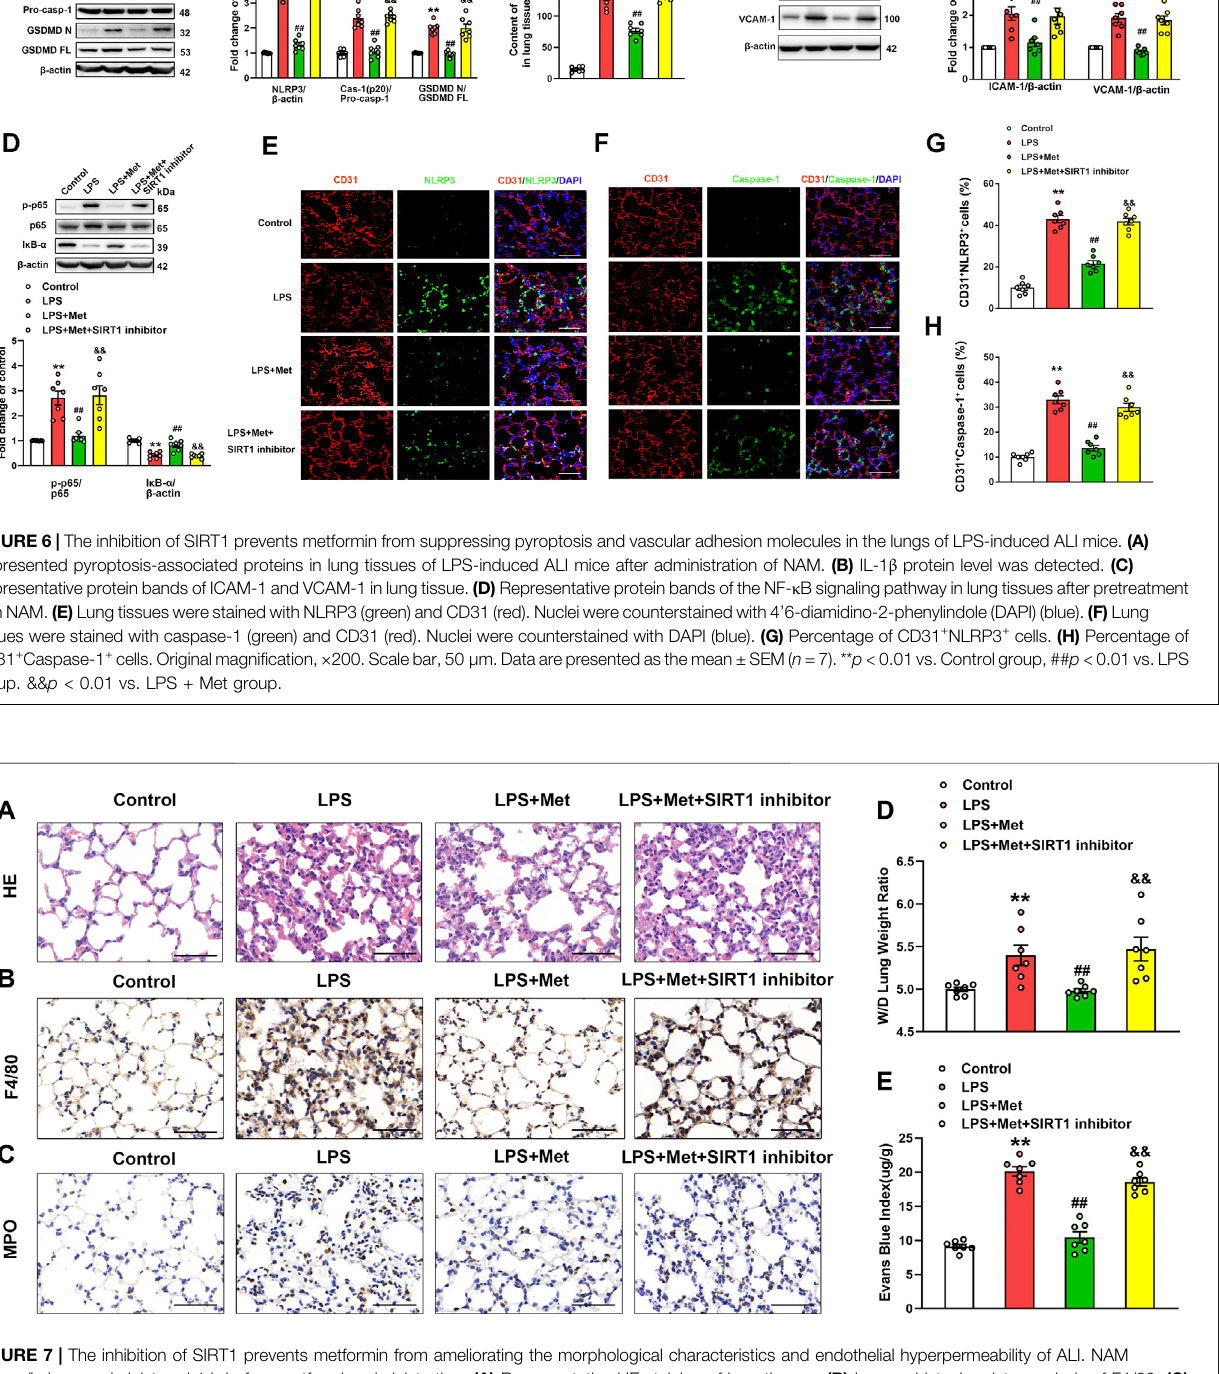
Frontiers in Pharmacology |